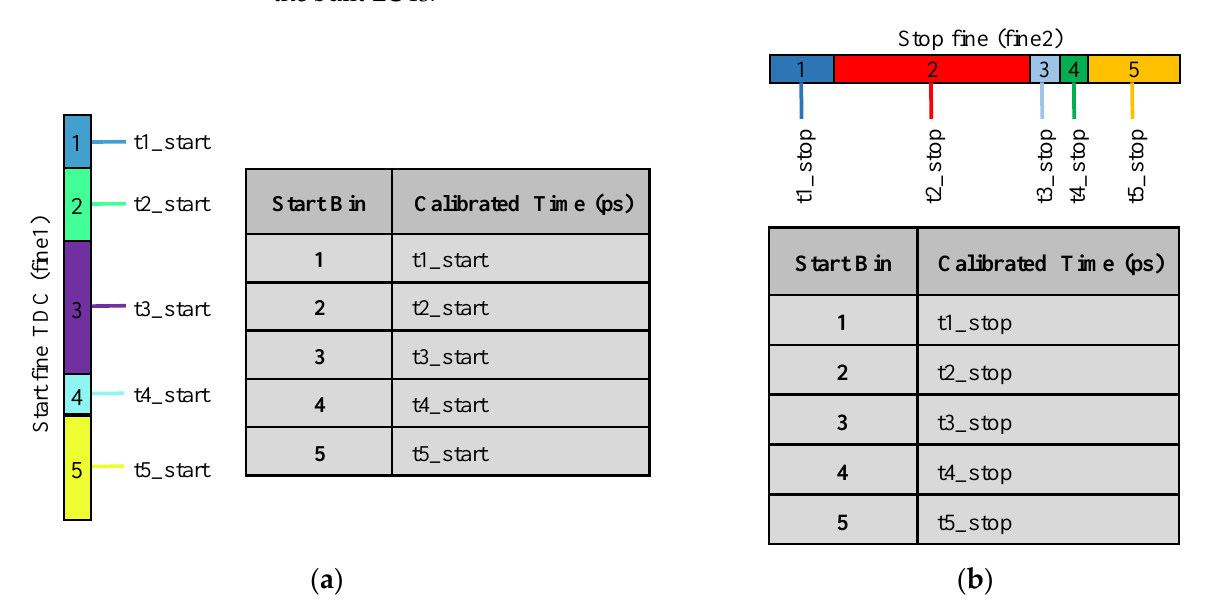
Figure 8. Lookup tables of the two fine TDCs: ( a ) Start fine TDC LUT; ( b ) Stop fine TDL LUT.